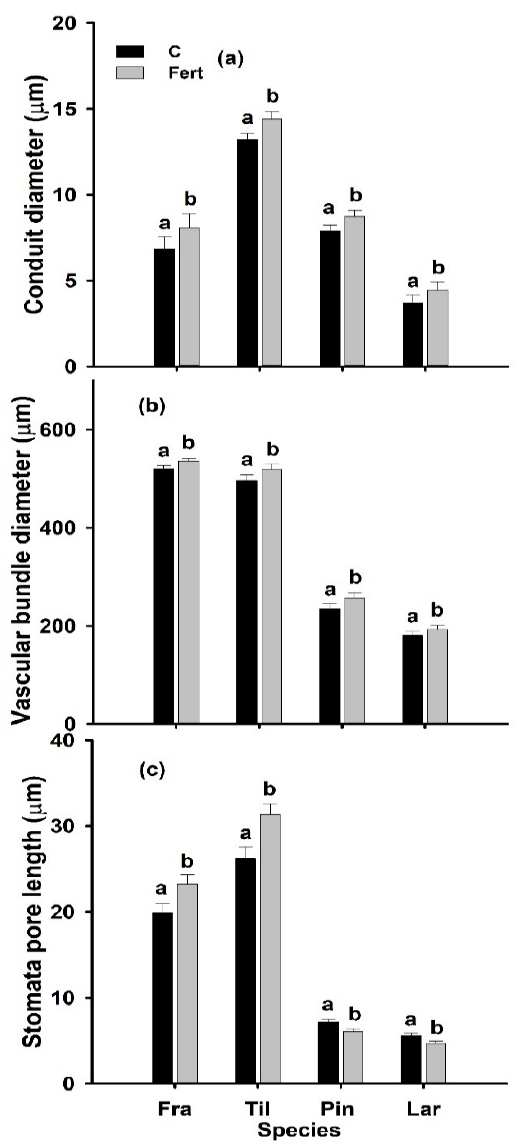
Figure 2. Conduit diameter ( μ m) ( a ), vascular bundle diameter ( μ m) ( b ), and stomata pore length ( μ m) ( c ) of mature, sun-exposed leaves/needles of two-year-old seedlings of Fraxinus mandshurica (Fra), Tilia amurensis (Til), Pinus koraiensis (Pin) and Larix gmelinii (Lar) at control (C; no additional N deposition; black bars) and after 10 g-N m − 2 yr − 1 (Fert; grey bars) additional nitrogen deposition in NE China. Within species, significant differences between treatments are indicated by different lower-case letters (Tukey’s HSD post hoc; p < 0.05; mean ± SE).